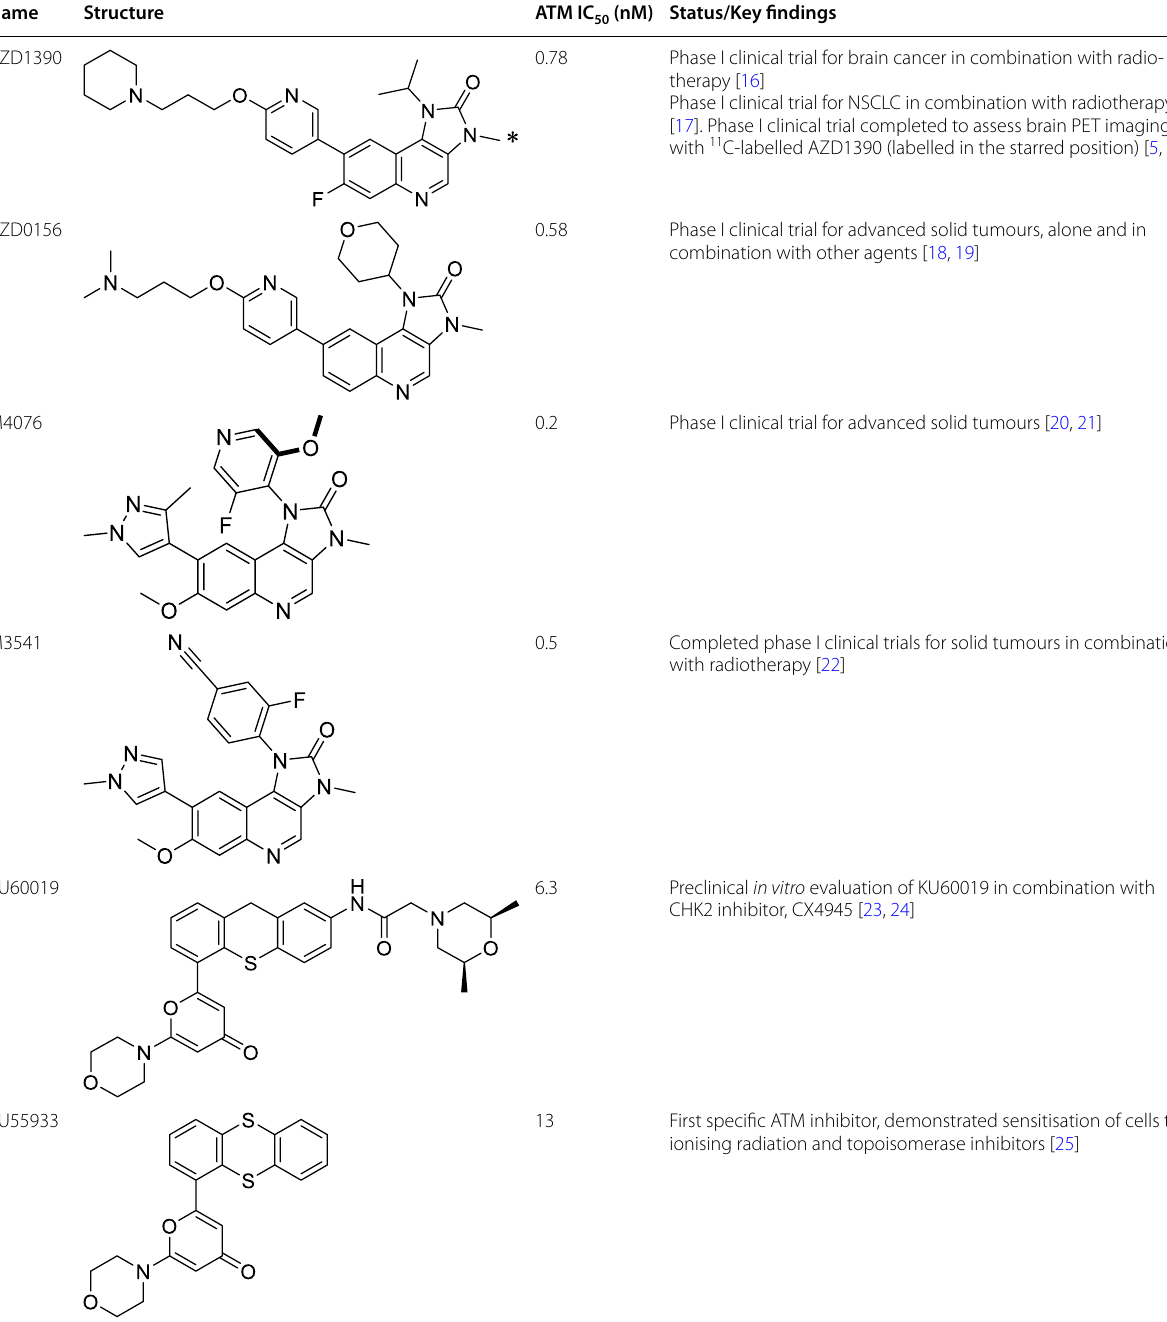
Table 1 ATM inhibitors under preclinical and clinical investigation